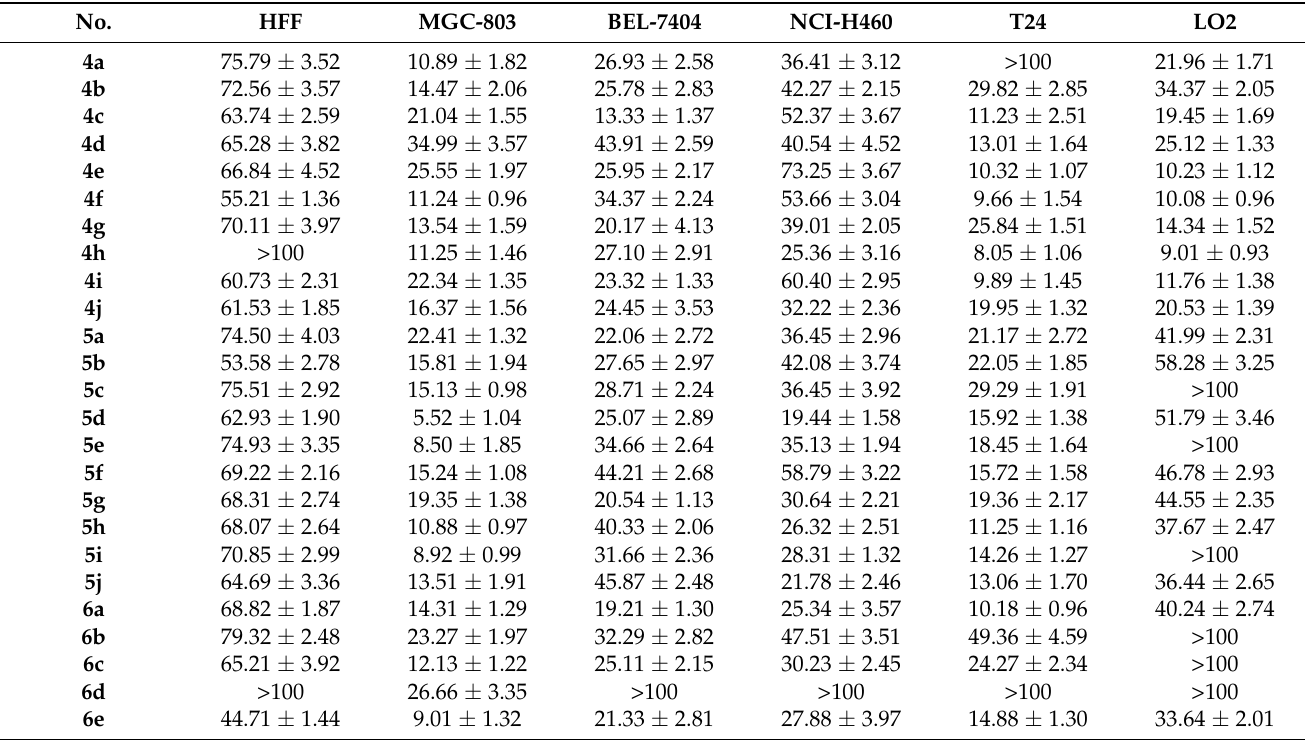
Table 1. Effect of compounds 4 , 5 and 6 against cell viability of different cell lines # ( µ